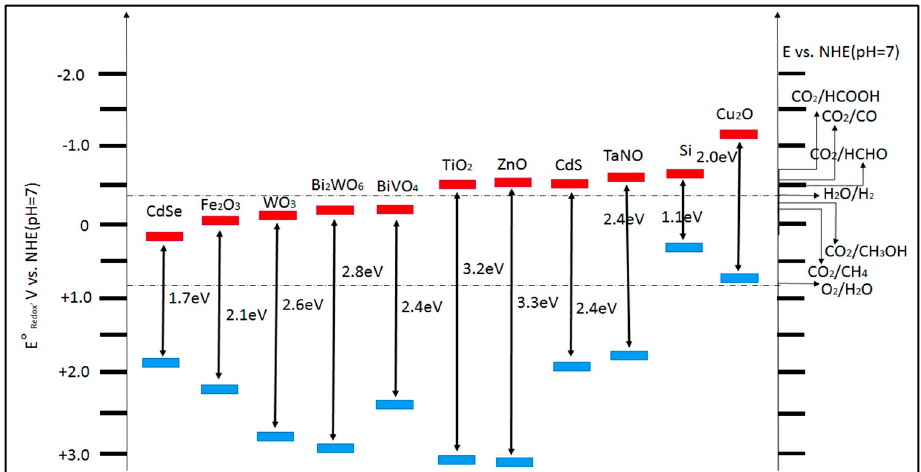
Figure 2. Schematic representation of conduction band, valence band potentials, and band gap energies of various semiconductor photocatalysts and relative redox potentials of the compounds involved in CO 2 reduction at pH 7 (Adapted from [22]).